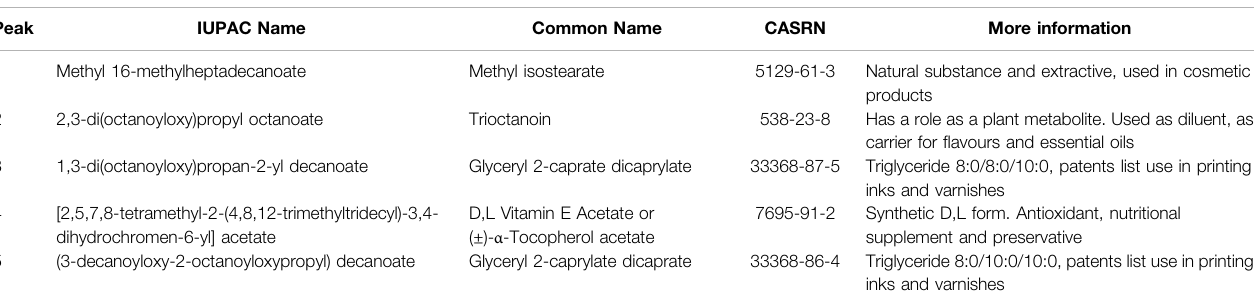
TABLE 3 | Chemical compounds detected in vitamin E acetate emission ( Figure 5